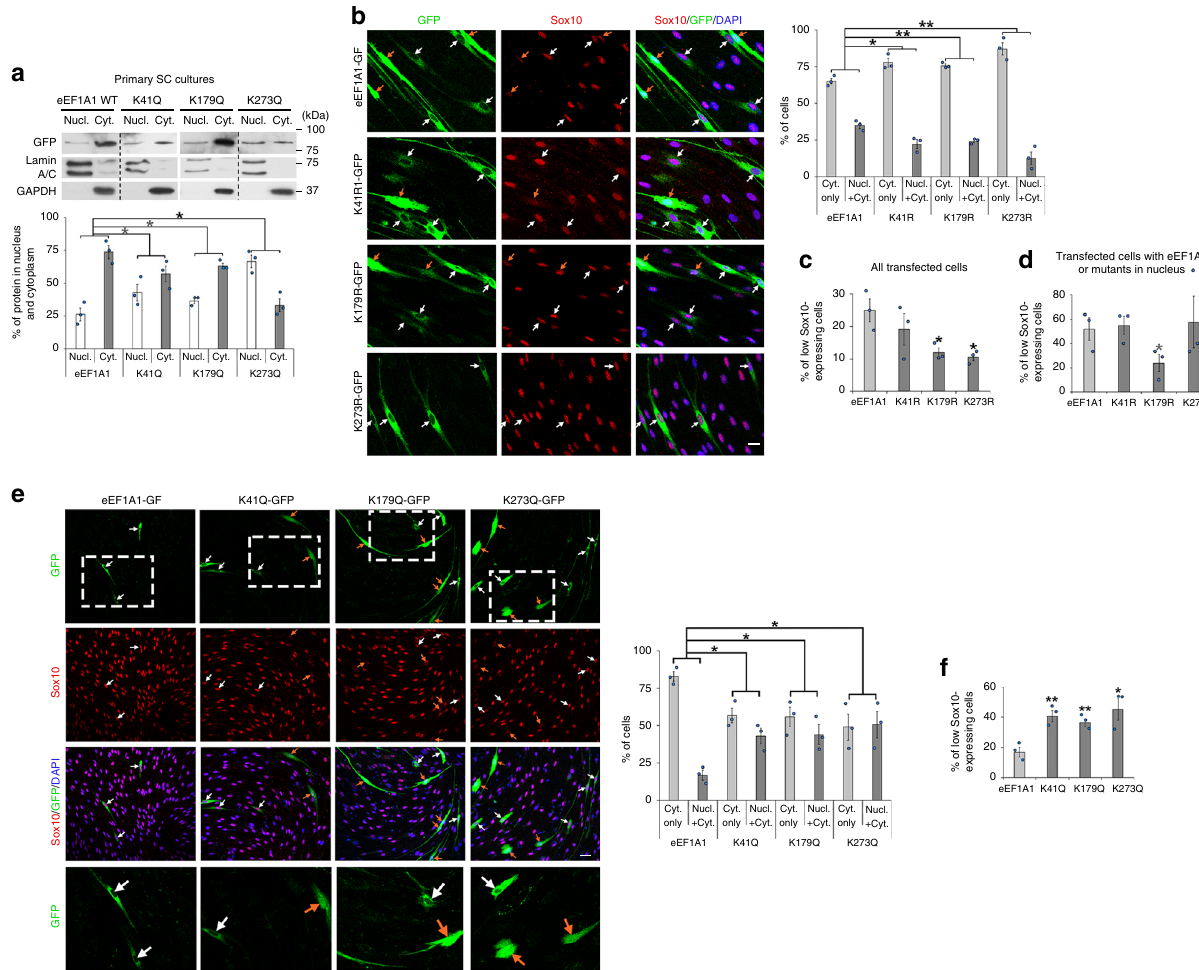
Fig. 4 EEF1A1 acetylation increases eEF1A1 nuclear localization and decreases Sox10 levels. a GFP Western blot in nuclear (Nucl.) and cytoplasmic (Cyt.) fractions of primary SCs cultured 1 day under de-differentiating conditions and transfected with eEF1A1-GFP, K41Q-GFP, K179Q-GFP or K273Q-GFP and % of protein localized in nucleus or cytoplasm normalized to Lamin A/C and GAPDH ( n = 3 independent experiments per group). b – d Sox10 immuno fl uorescence with GFP fl uorescence and DAPI (nuclei) labeling in SCs overexpressing eEF1A1-GFP, K41R-GFP, K179R-GFP or K273R-GFP and cultured under de-differentiating conditions for 3 days, and % of cells with eEF1A1 or mutants localized in cytoplasm only (Cyt. only) or in nucleus and cytoplasm (Nucl. + Cyt., b ) or % of low Sox10-expressing cells ( c , d ). N = 3 independent experiments per group, 18-84 cells counted per group per n . e , f Sox10 immuno fl uorescence with GFP fl uorescence and DAPI (nuclei) labeling in SCs overexpressing eEF1A1-GFP, K41Q-GFP, K179Q-GFP or K273Q- GFP and cultured under proliferating conditions for 2 days, and % of cells with eEF1A1 or mutants localized in cytoplasm only or in nucleus and cytoplasm of SCs ( e ) or % of low Sox10-expressing cells ( f ). The lower images are magni fi cations of the dashed white boxes on the upper images. N = 3 independent experiments per group, 17 – 71 cells counted per group per n. Arrows show transfected SCs. Orange arrows indicate SCs where eEF1A1 or the mutants are present in the nucleus of SCs. Scale bars: 10 µ m ( b ), 20 µ m ( e ). Data are presented as mean values± SEM. Unpaired one-tailed (gray asterisks) or two- tailed (black asterisks) Student ’ s t -tests, p values = 0.029415 ( a , K41Q), 0.04884 ( a , K179Q), 0.0329 ( a , K273Q), 0.023698 ( b , K41R), 0.008772 ( b , K179R), 0.00946 ( b , K273R), 0.189827 ( c , K41R), 0.027448 ( c , K179R), 0.018314 ( c , K273R), 0.405588 ( d , K41R), 0.03836 ( d , K179R), 0.406686 ( d , K273R), 0.011923 ( e , K41Q), 0.019373 ( e , K179Q), 0.021749 ( e , K273Q), 0.009059 ( f , K41Q), 0.009399 ( f , K179Q), 0.02223 ( f , K273Q). Source data are provided as a Source Data fi